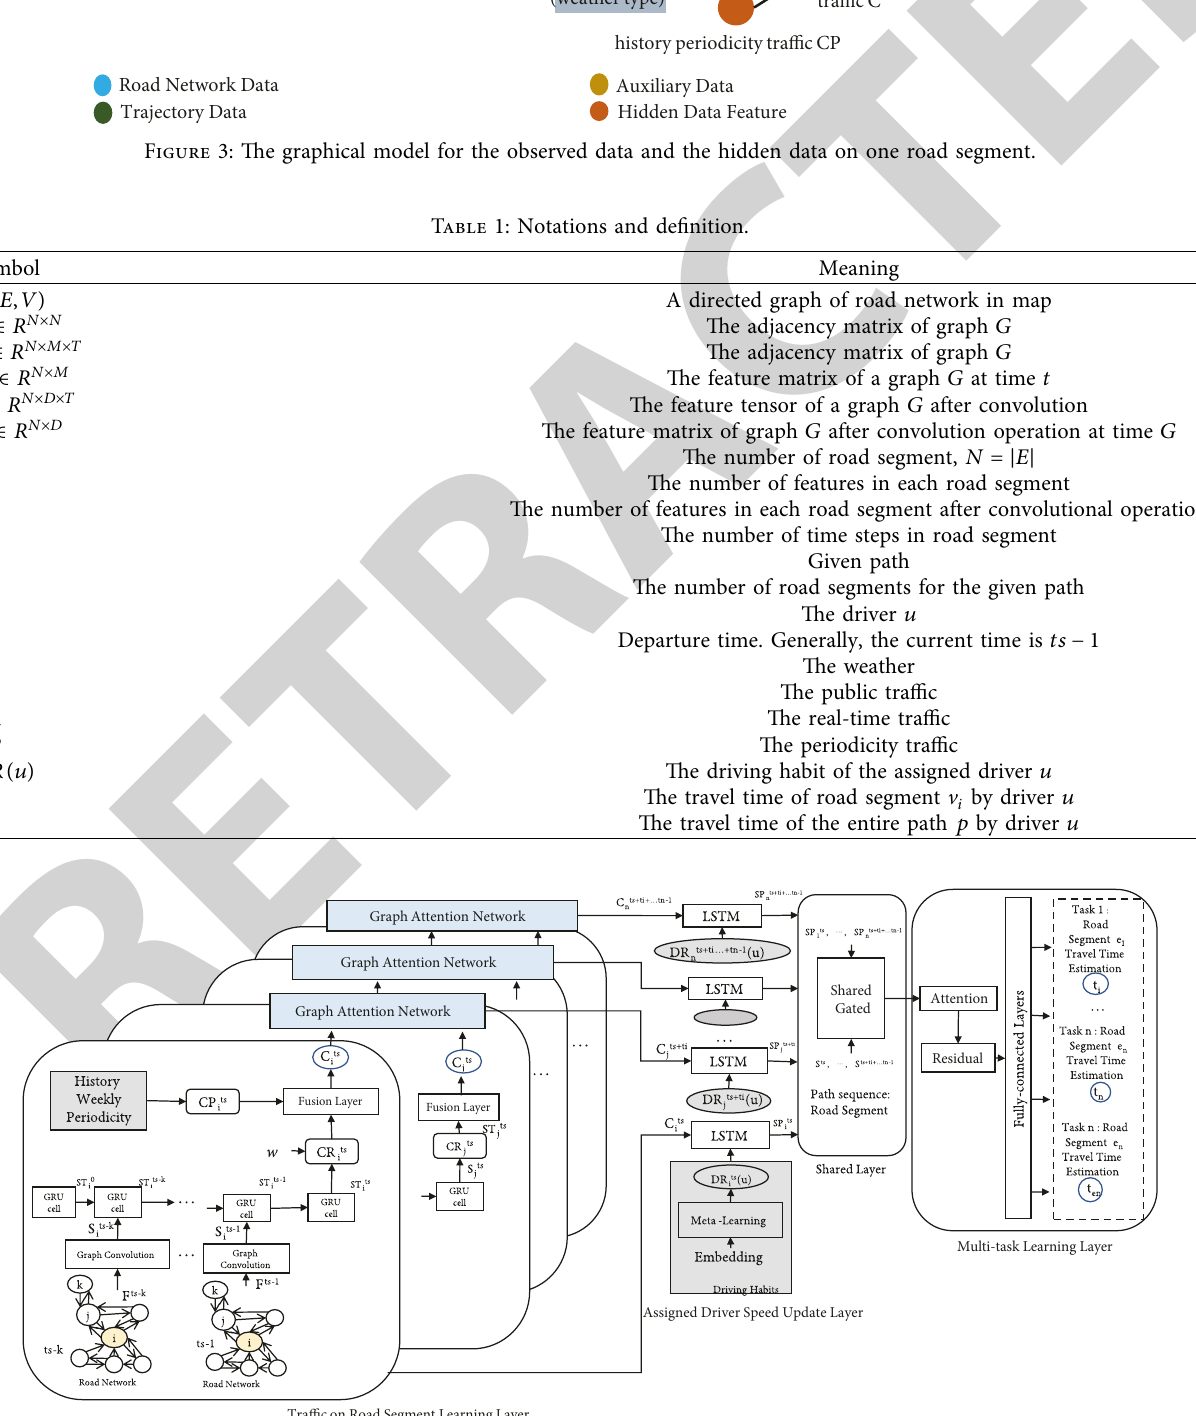
Figure 4: The architecture of DRTTE : GRU: gated recurrent unit; LSTM: long short-term memory.